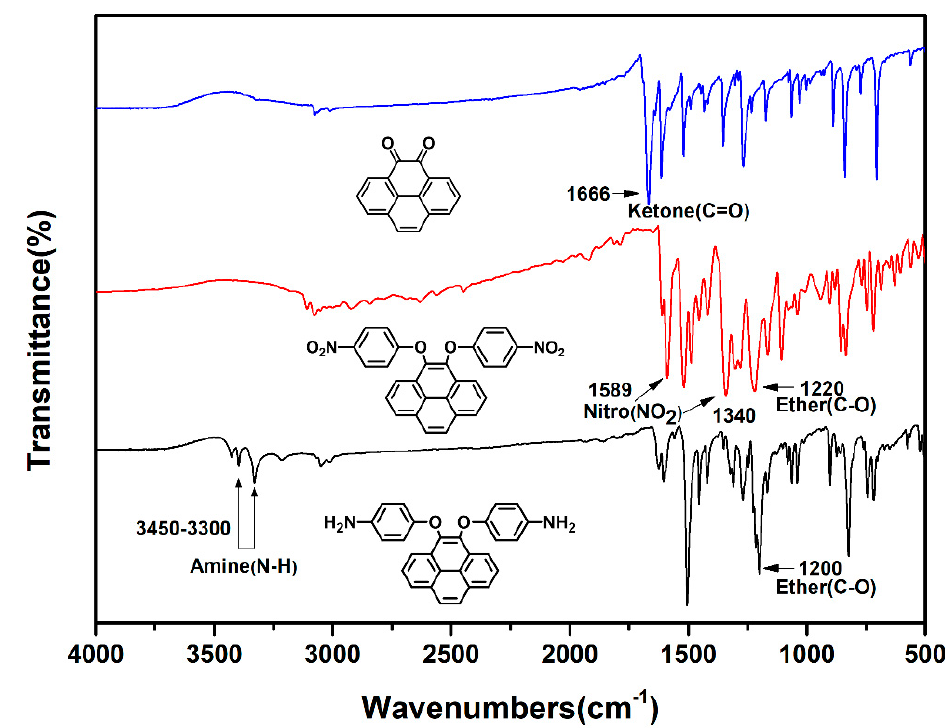
Figure 1. FT-IR spectra of pyrene-derived compounds and monomers 1 – 3 .